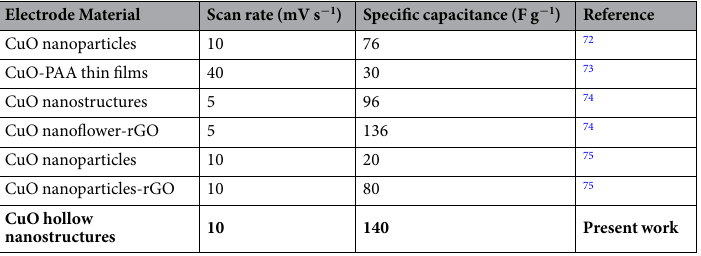
Table 2. Comparison of present electrochemical result with some recent results on CuO based electrode